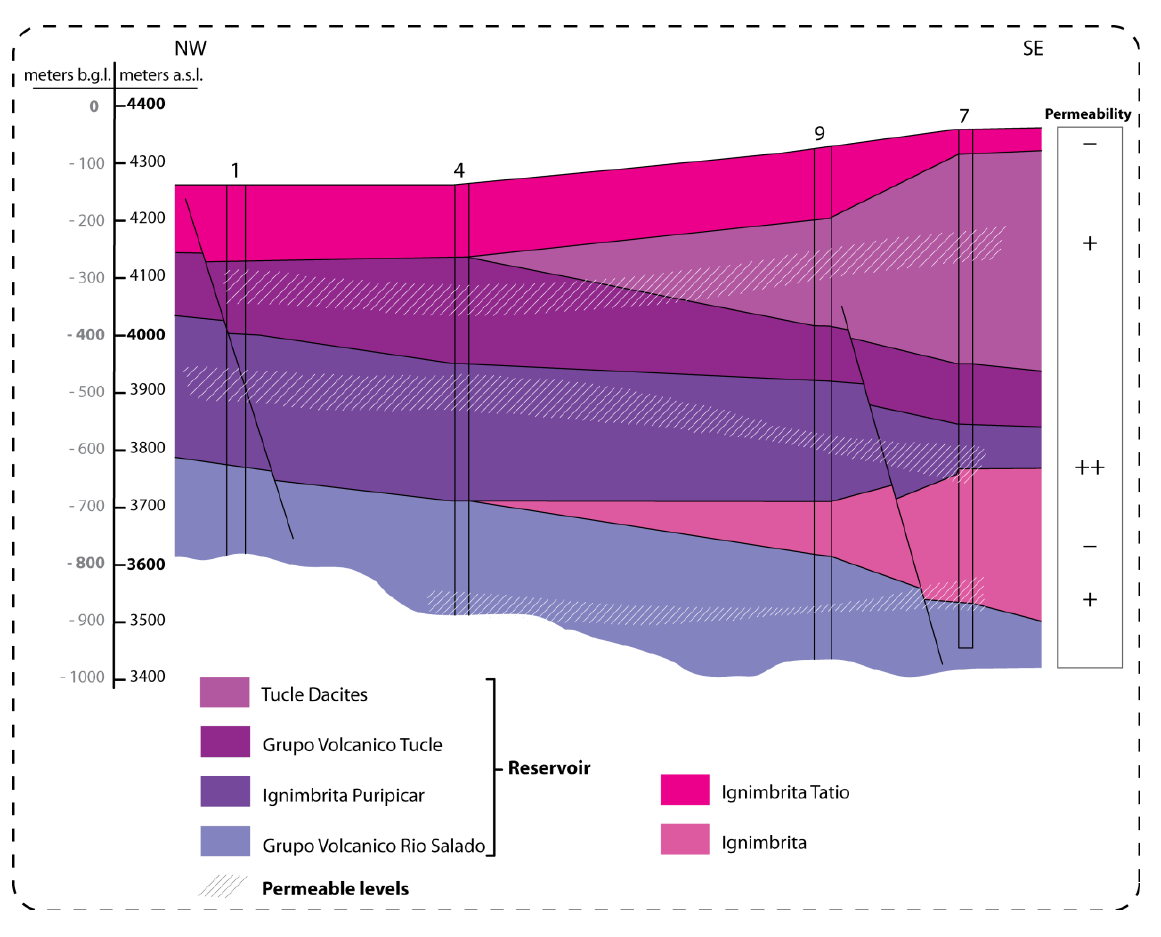
Figure 3. The geological profile from NW-SE of the El Tatio graben through the boreholes numbered 1, 4, 9 and 7 (modified from [9]). For further details see text in the previous page; paragraph relative to